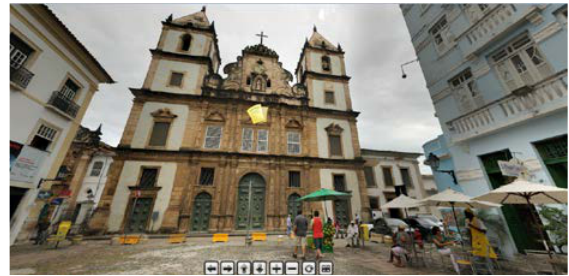
Figure 10. Virtual panoramic tour joints the data sheet (by hotspot connection) stored in the GIS